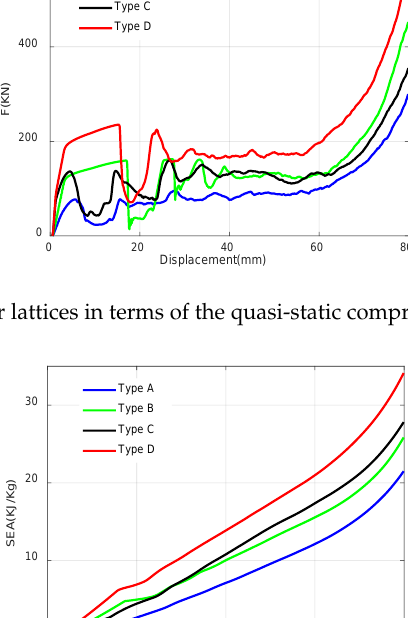
Figure 22. Comparison of four lattices in terms of the quasi-static compressive force and displacement.